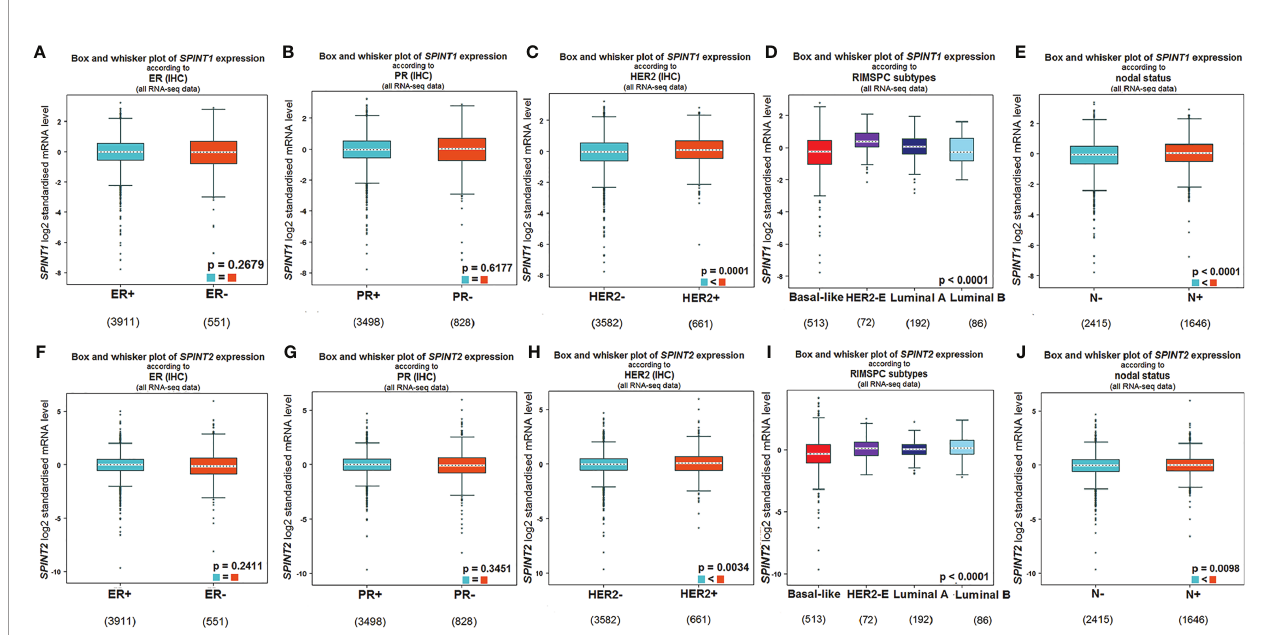
FIGURE 2 | SPINT1/2 expression correlated with HER2 and node status. Relationship between SPINT1 expression with ER (A) , PR (B) , HER2 (C) , molecular subtypes (D) and node status (E) . Relationship between SPINT2 expression with ER (F) , PR (G) , HER2 (H) , molecular subtypes (I) and node status (J) from bc-GenExMiner